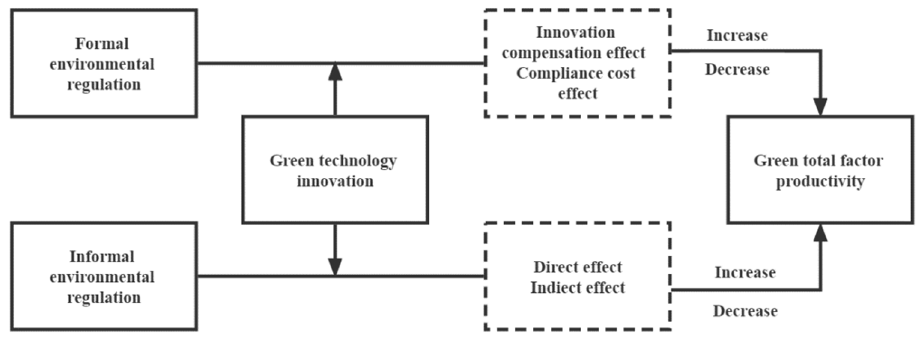
Figure 1. Theoretical framework.